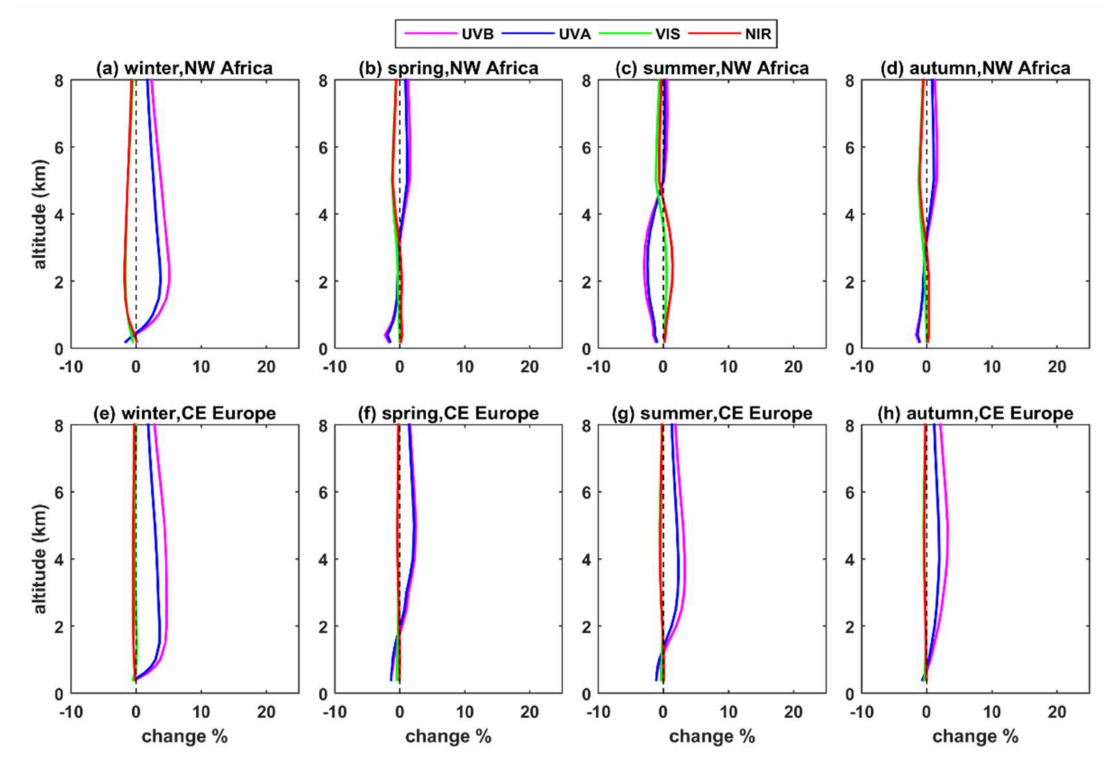
Figure A12. Same as Figure 9, but for SZA = 30 ◦ instead of SZA = 60 ◦ .